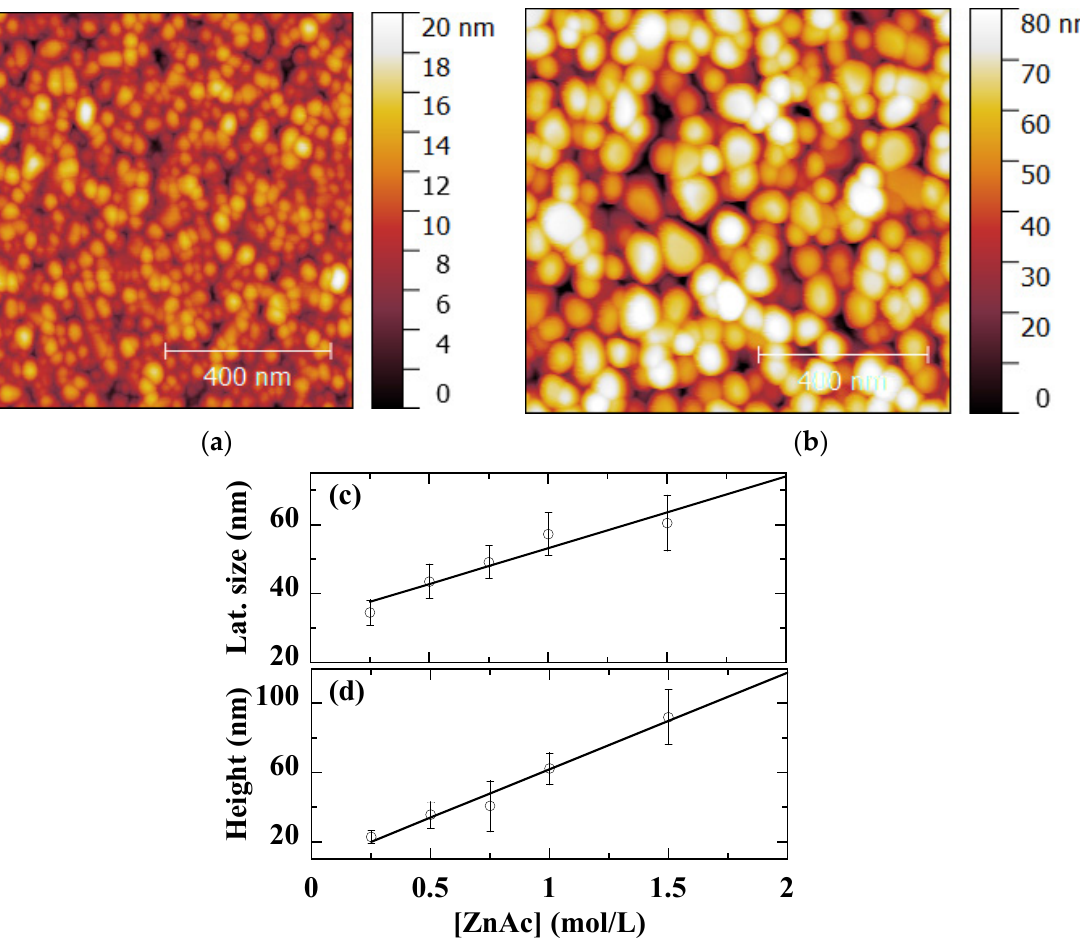
Figure 4. 1 µ m × 1 µ m AFM micrographs of sol-gel spin-coated ZnO samples obtained with [ZnAc] = 0.25 mol/L ( a ) and 1.0 mol/L ( b ). AFM lateral size ( c ) and height ( d ) of sol-gel spin-coated ZnO samples obtained with various [ZnAc]. The straight lines are provided as guides for the eye.